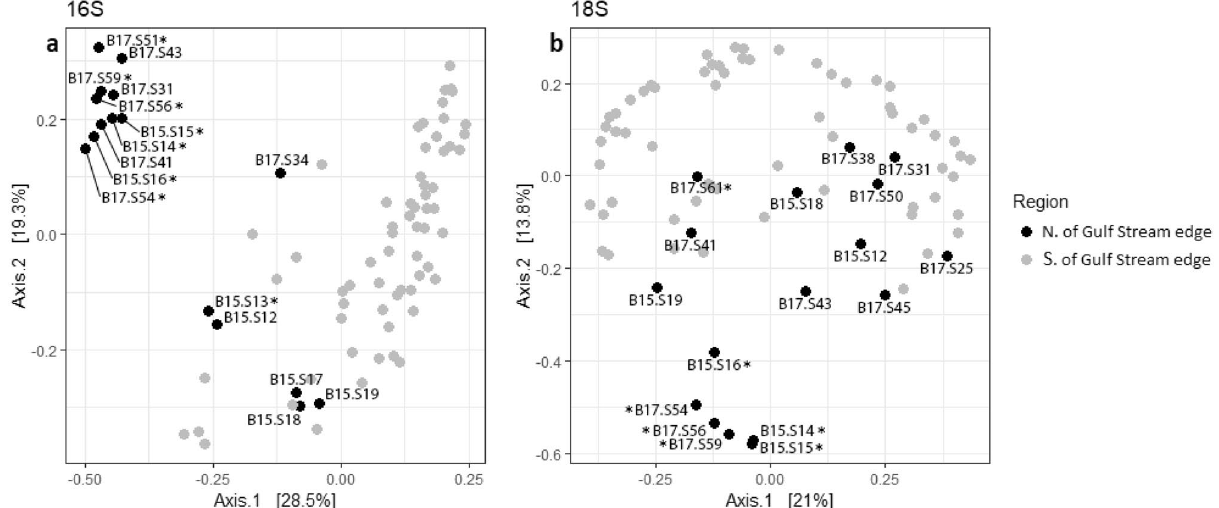
Figure 4. Principal Coordinates Analysis (PCoA) of ( a) prokaryotic 16S and ( b) eukaryotic 18S samples, ordinated using weighted Bray–Curtis dissimilarity. Samples are shaded based on whether they were collected north or south of the northern wall of the Gulf Stream in that year as determined from monthly EN4 temperature data 42 . Samples denoted with asterisks originate from the Mid-Atlantic Bight. Figure created in R 3.5.2 (https ://www.r-proje ct.org/).